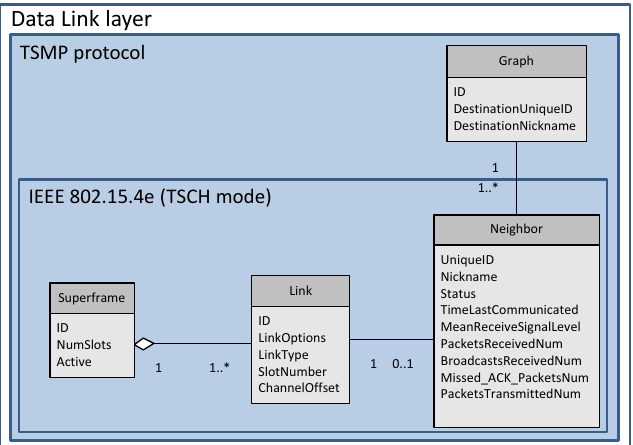
Figure 4. Communication tables stored in each device and their relationship in TSCH and